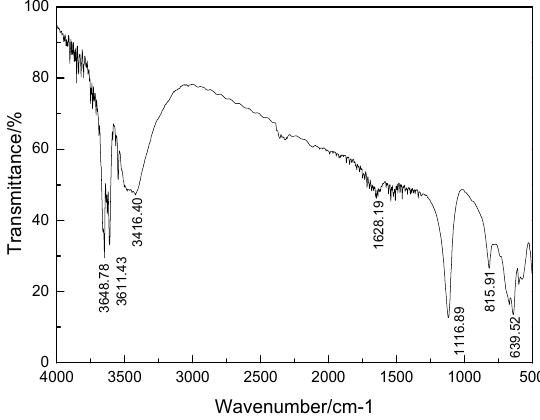
Figure 17. Fourier transform infrared spectroscopy FI-IR pattern of the hydrothermal product.